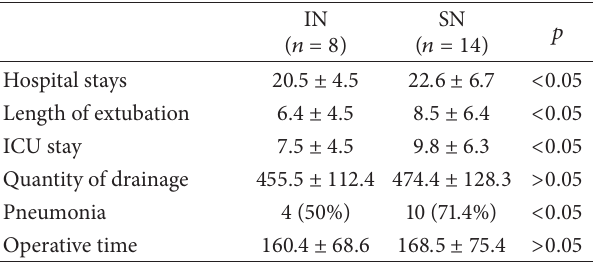
Table 4: Comparison of subgroups of postoperative myasthenic crisis between two